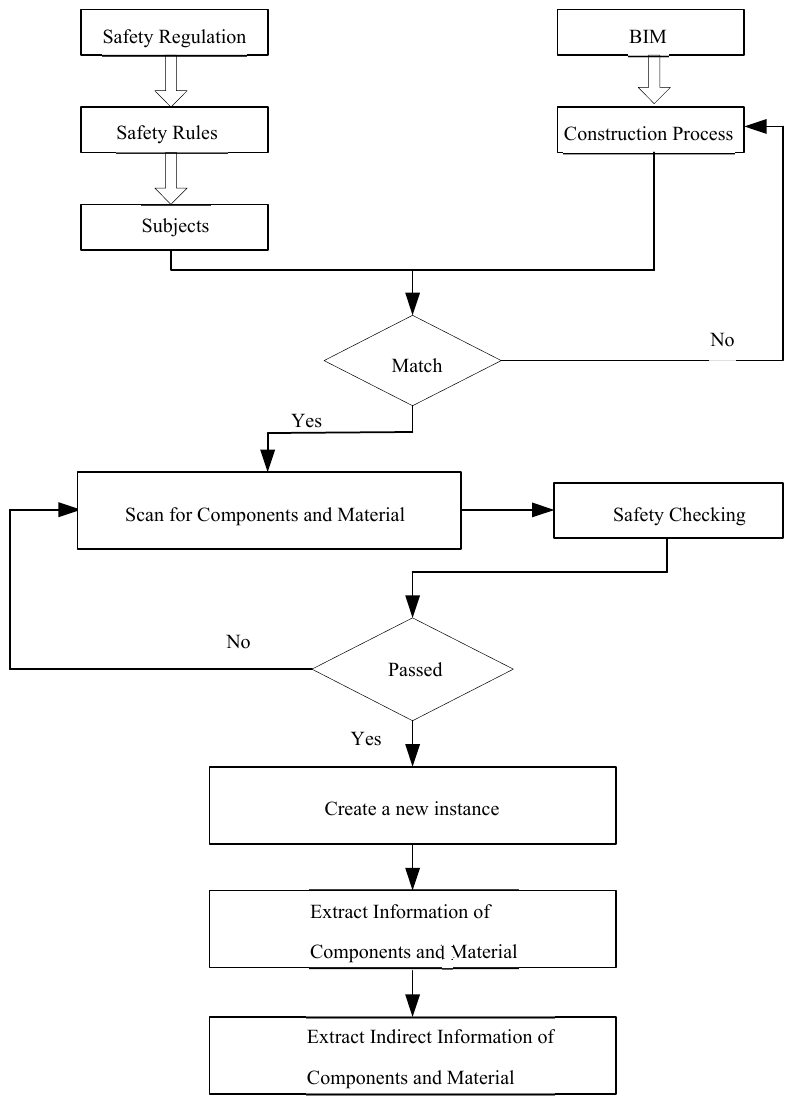
Figure 9. Linking building components and construction processes to safety rules.